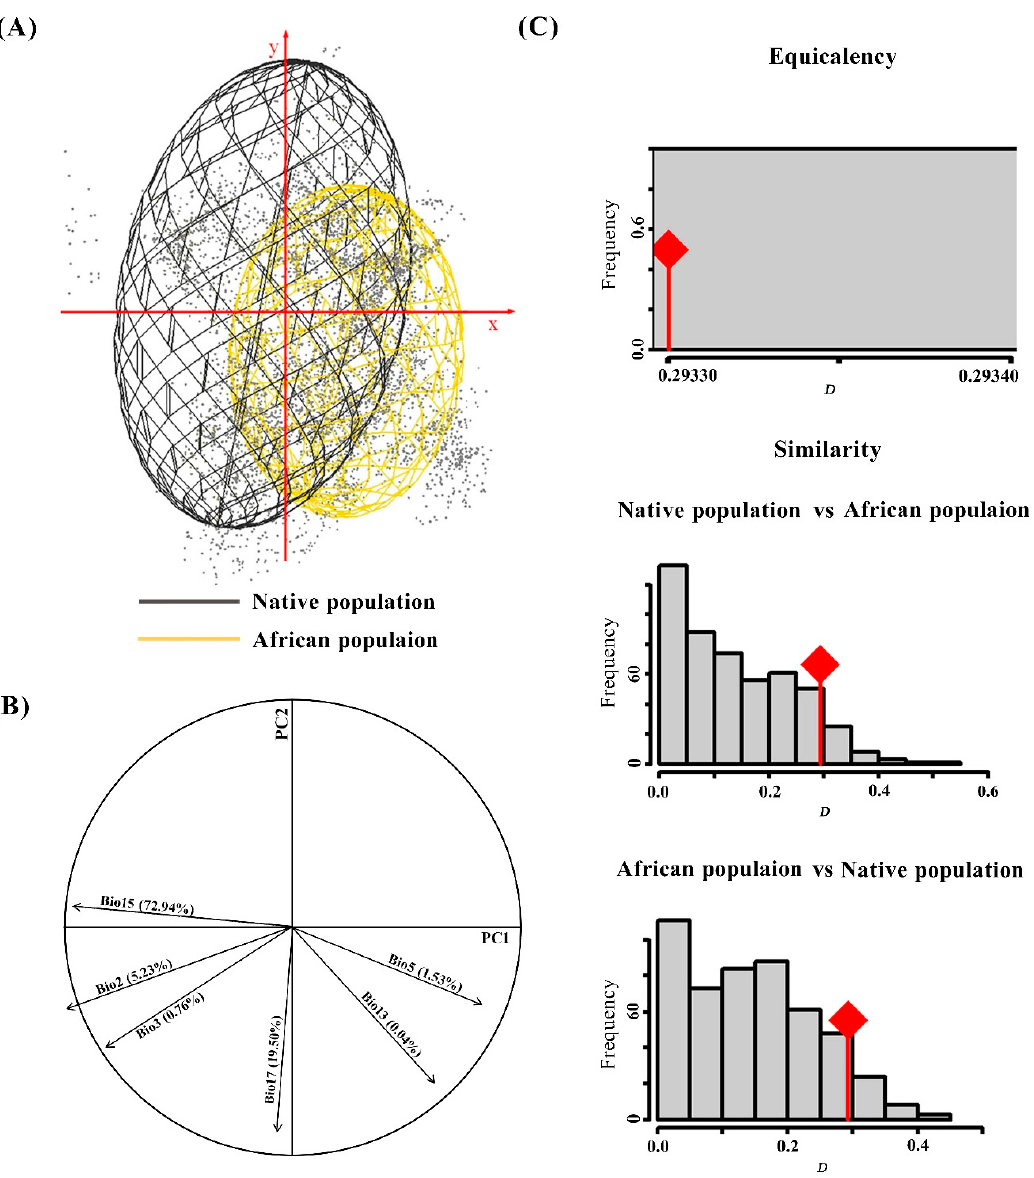
Figure 2. Comparison of Spodoptera frugiperda populations between native and Africa. ( A ) Occurrences in a two-dimensional environmental space; axes are the first two principal components; and gray points are the environmental background of the study area. ( B ) The contribution of the climatic variables on the two axes of the PCA and the percentage of each variable. ( C ) Histogram of the niche equivalency and niche similarity tests between native and Africa ranges. The D stands for Schoener’s D overlap value, red lines with a diamond represent the observed niche overlap, and gray bars represent simulated niche overlaps.